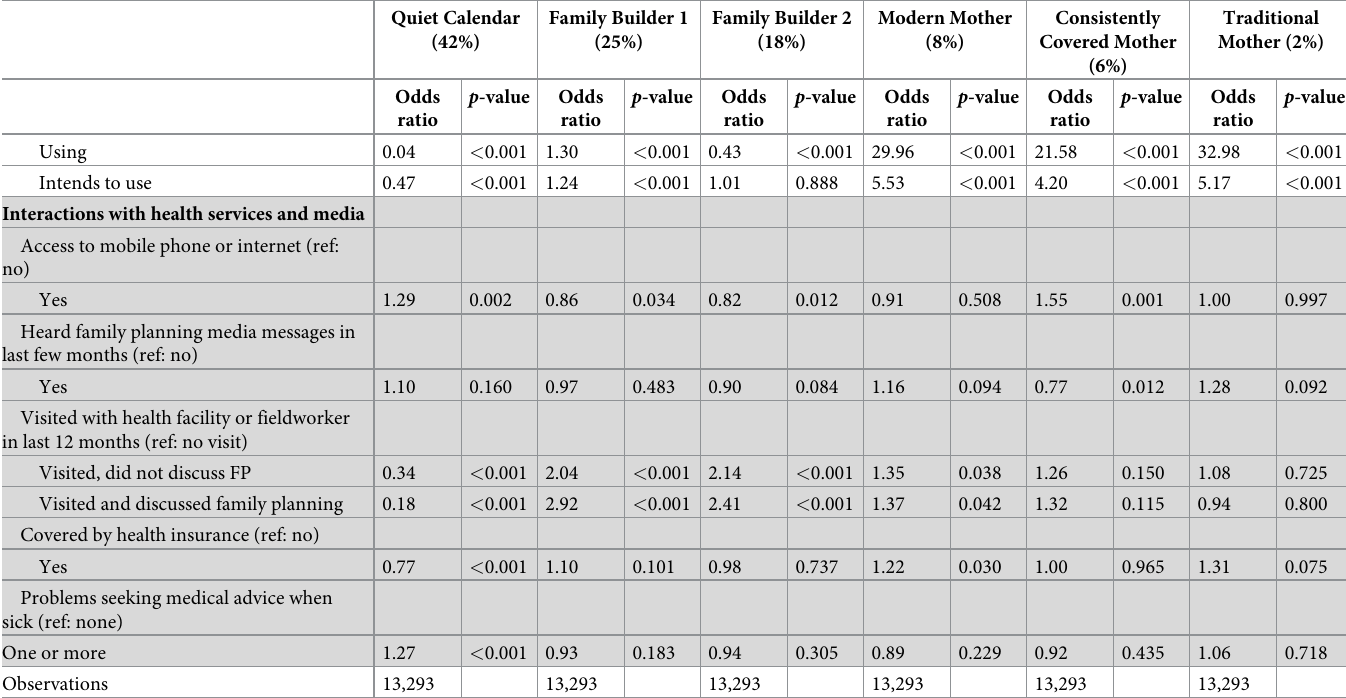
The unique pattern of association between age and membership in the Quiet Calendar clus- ter shown in Table 2 is not found in any of the other five clusters. Compared with women in the middle age group (age 30–34), both older women (OR = 2.5–10.5, p < 0.001) and adolescent women (OR = 1.5, p < 0.001) have higher odds of belonging to the Quiet Calendar cluster, while women in their 20s have lower odds (OR = 0.6, p <